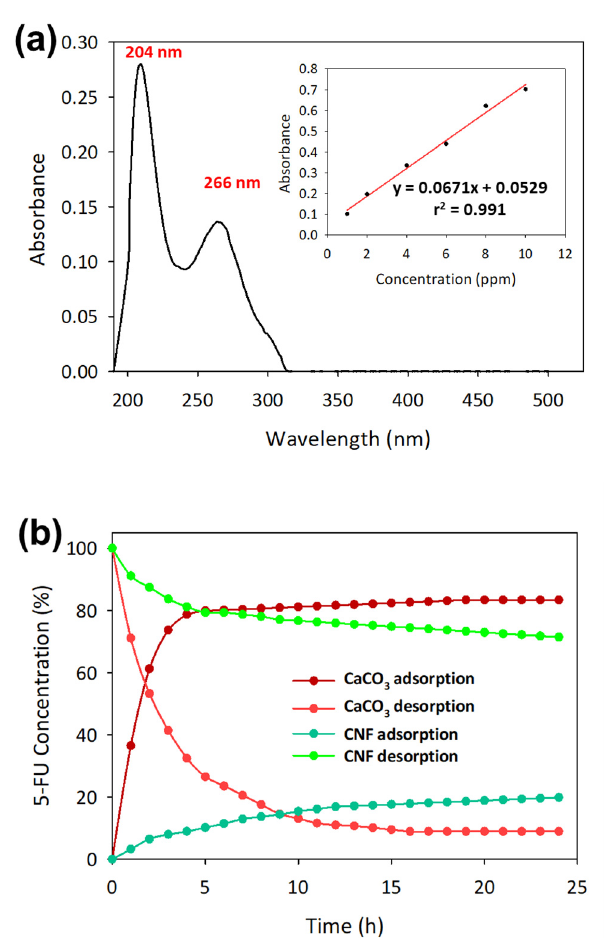
Figure 3. ( a ) Spectrum of 5-fluorouracil (5-FU) using a spectrophotometer (inset shows linear calibration curve according to the Beer-Lambert law) and ( b ) the adsorption-desorption kinetics of 5-FU using casted films of CNF and CaCO 3 . The data are presented as mean ( n = 3).